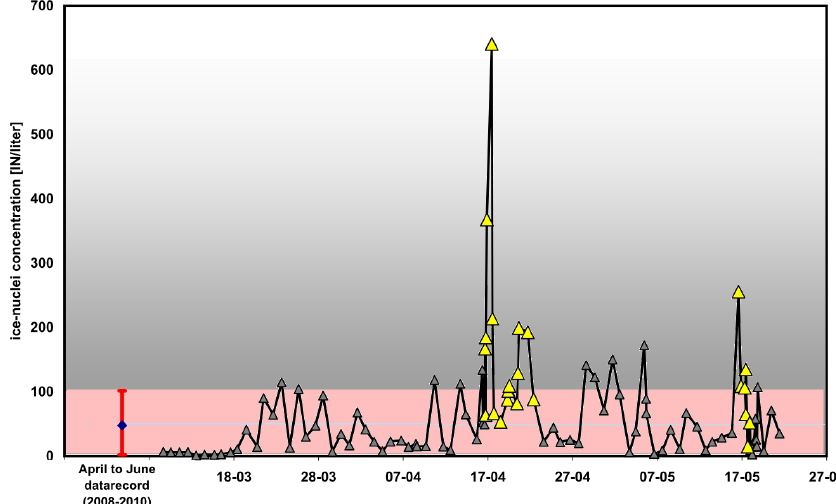
Fig. 1. Number concentration of atmospheric ice nuclei (at − 18 ◦ C and water saturation) at the Taunus Observatory (TO) in central Germany during April–May 2010. The blue line and pink banded area are the seasonal average and standard deviation, respectively, for the months of April through June